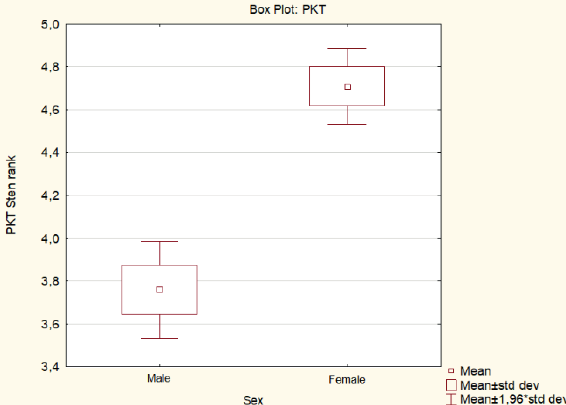
Figure 5. The differences of seeking social contacts rank between sexes. Box